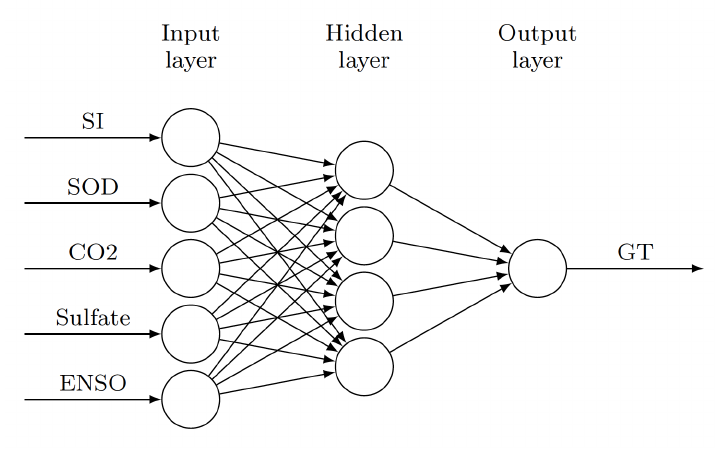
Figure 2. ANN model to estimate Global